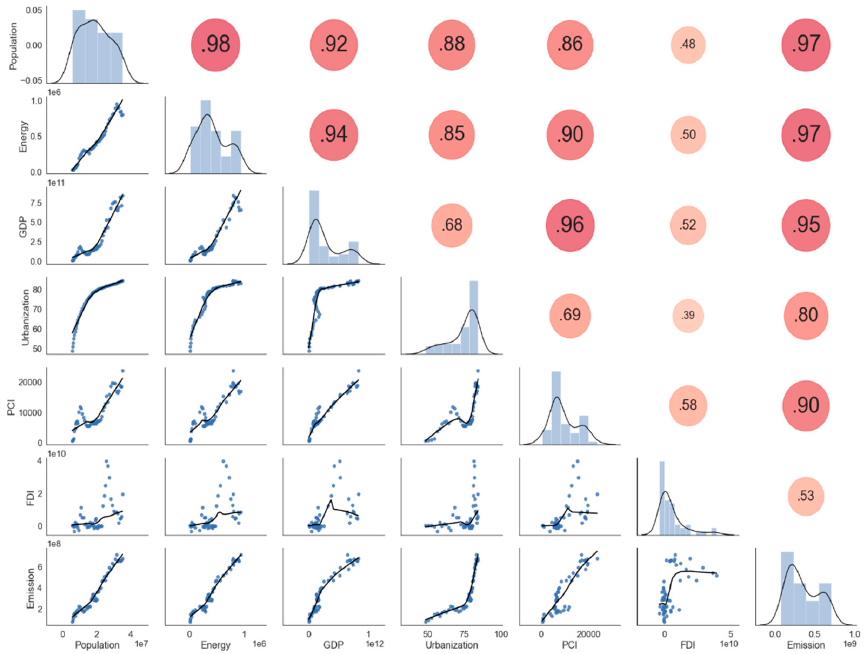
Figure 1. Sca tt erplot of full dataset for Saudi Arabia (Note: 1e7 is equal to 1 × 10 7 ). Figure 1. Scatterplot of full dataset for Saudi Arabia (Note: 1e7 is equal to 1 × 10 7 ).